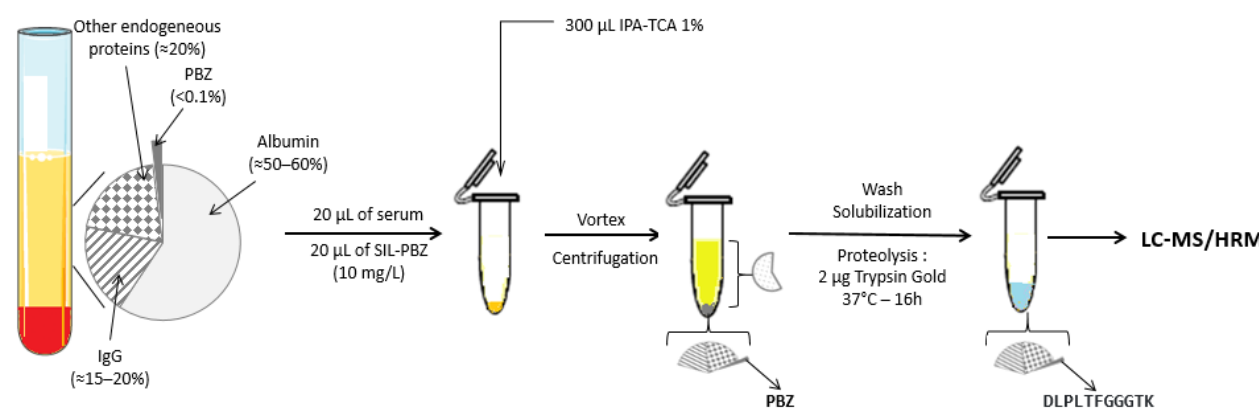
Figure 1. Sample preparation protocol. PBZ: pembrolizumab; IgG: immunoglobulin G; DLPLTFGGGTK: LC8 surrogate peptide; IPA-TCA 1%: isopropanol and 1% of trichloroacetic acid.